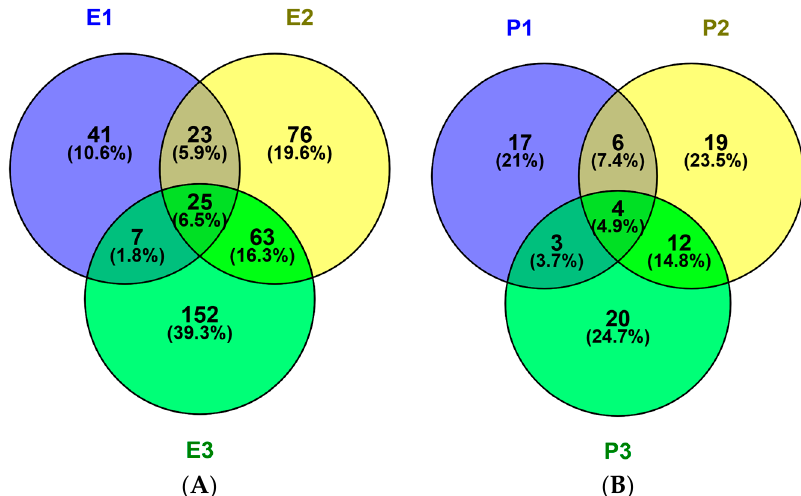
Table1. Peptides in enzymatic hydrolysates of P1–P3 M. edulis protein fractions.